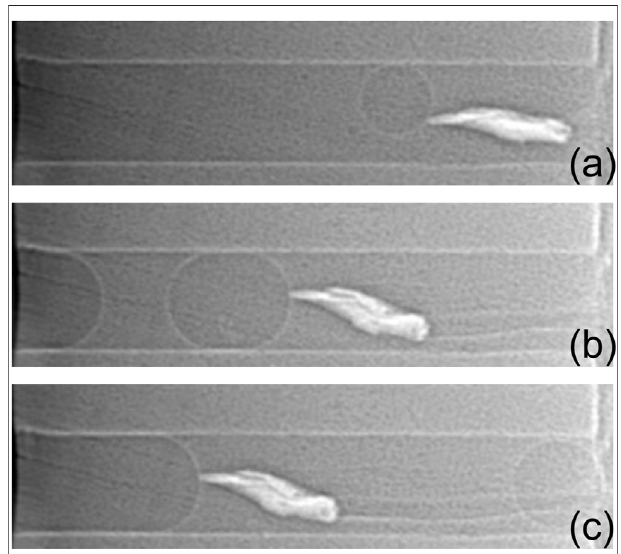
FIGURE 9 | Projection images of the AM3-1 nozzle using MicroX1 fuel blend at three different injection counts: (A) 4,878, (B) 13,878, (C) 25,878.